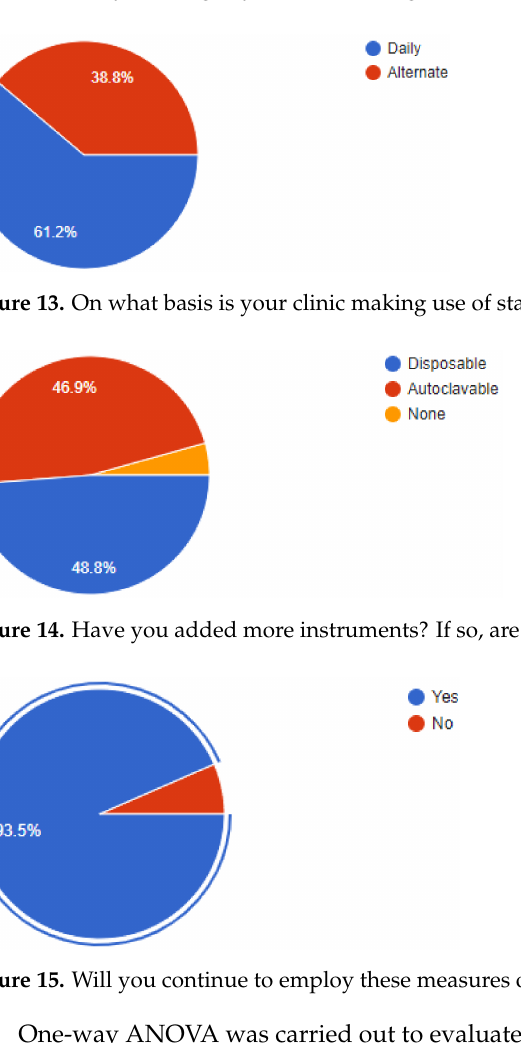
Figure 12. Are you using any of the following?